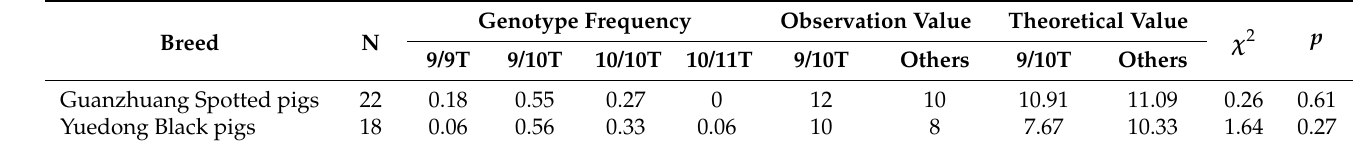
Table 4. Genotypic frequency of tract 2 on IGF1 among commercial